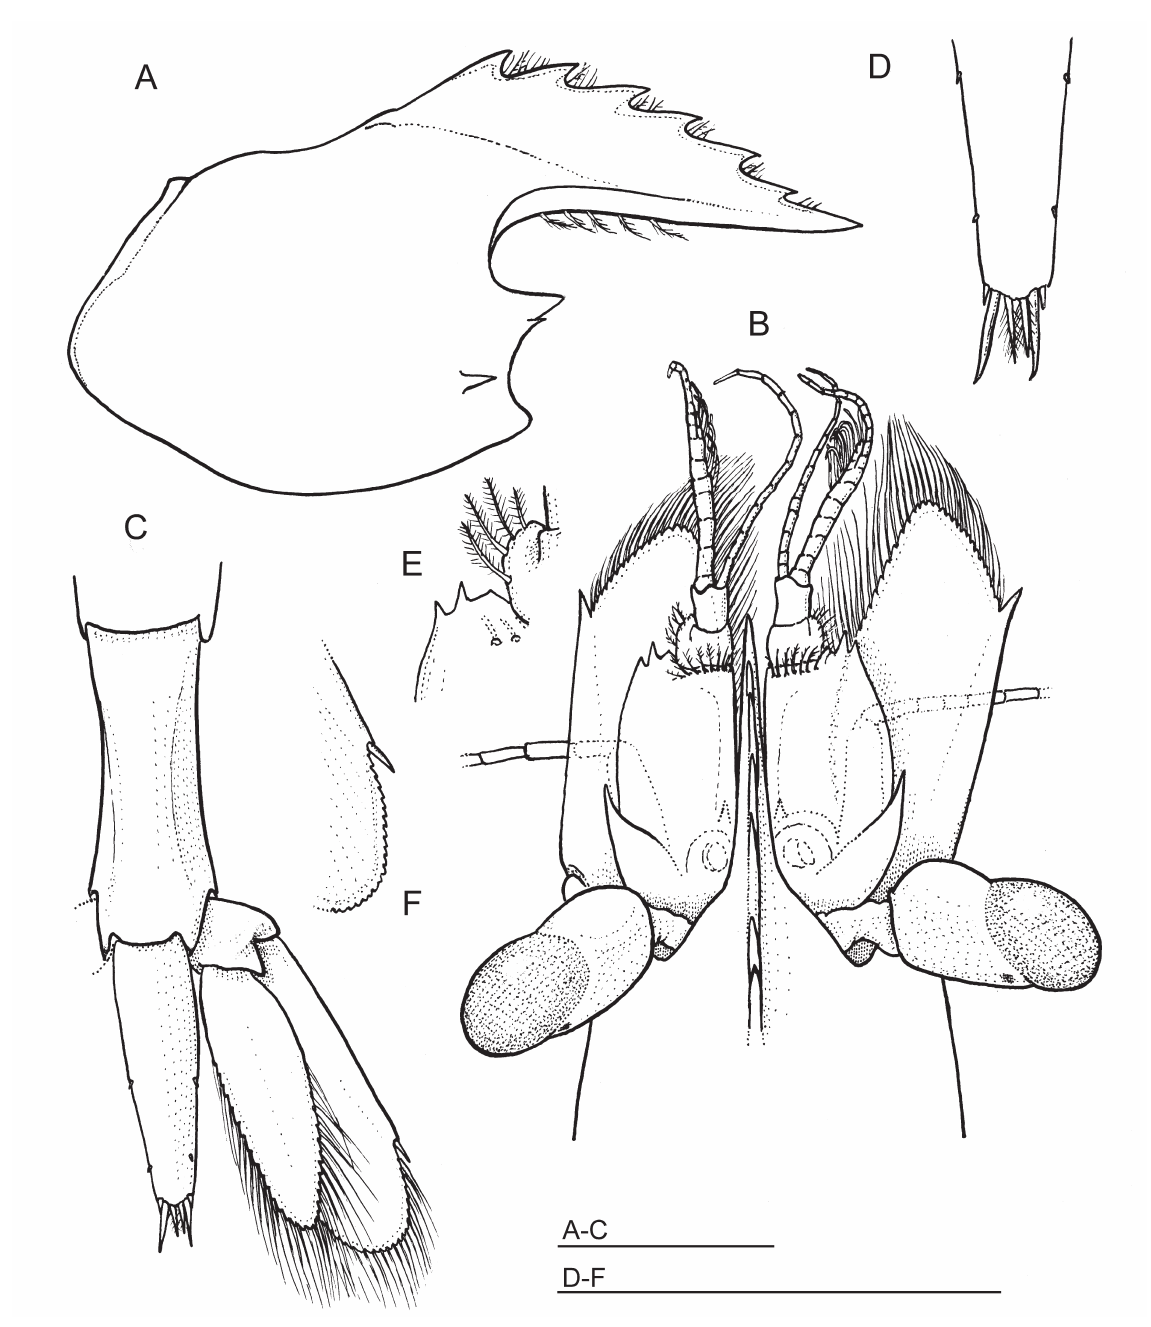
Fig. 2. Hamodactylus paraqabai sp. nov., ovigerous ♀ , holotype (PoCL 1.5 mm; Madang, Papua New Guinea ). A . Carapace and rostrum, lateral. B . Anterior cephalothorax and appendages, dorsal. C . Sixth abdominal segment, telson and uropod, dorsal. D . Posterior part of telson, dorsal. E . Antennule, detail of distolateral angle of proximal segment and lateral border of intermediate segment. F . Distolateral angle of uropodal exopod, dorsal. Scale bars = 1